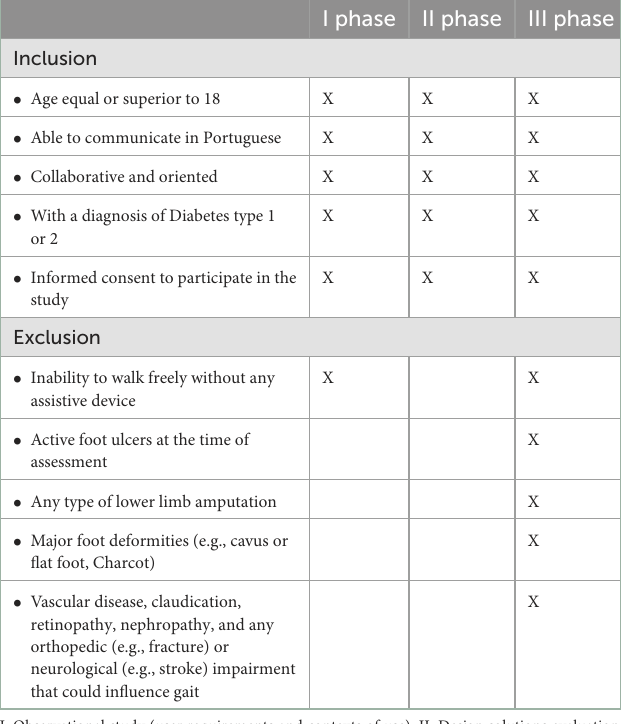
I phase II phase III